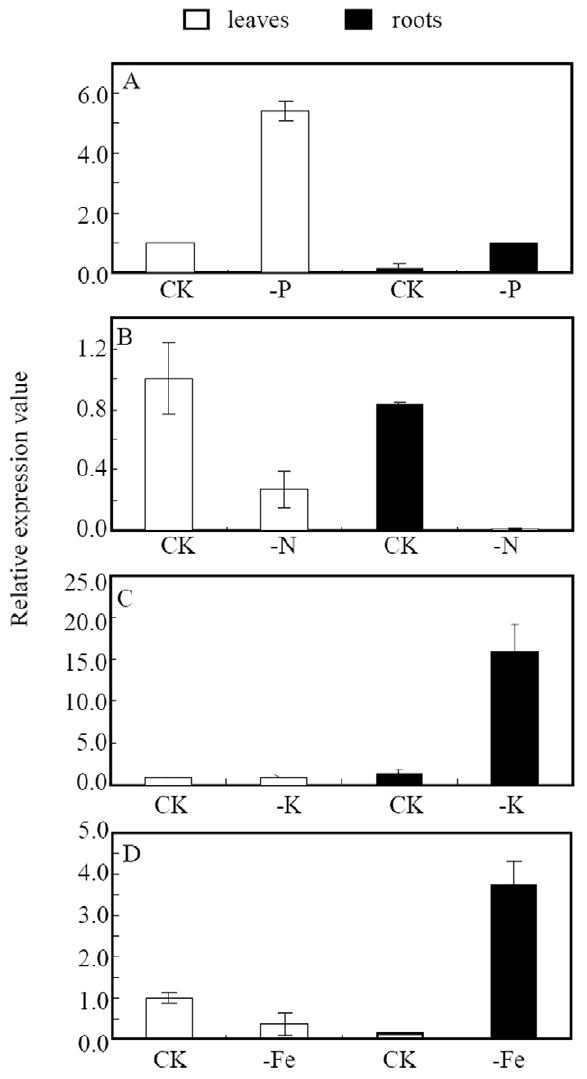
Figure 5. Expression of P, N, K or Fe responsive genes to different nutrient stresses. 14-day old soybean seedlings were treated with N ( 2 N), K ( 2 K) and Fe ( 2 Fe) deficiencies (see Experimental procedures for details). Seedlings grown under normal solution were used as controls (CK, added 500 m M P as KH 2 PO 4 ). The expression levels in shoots and roots were analyzed by quantitative real-time PCR. Soybean gene PLDZ (Glyma20g38200) was used as low P responsive gene (A), NiR (Glyma02g14910) for low N treatment (B), HAK (Glyma3g42480) for low potassium treatment (C) and IRT (Gly- ma07g34930) for low Fe treatment (D), respectively. Each bar was the mean of three biological replications with standard error.